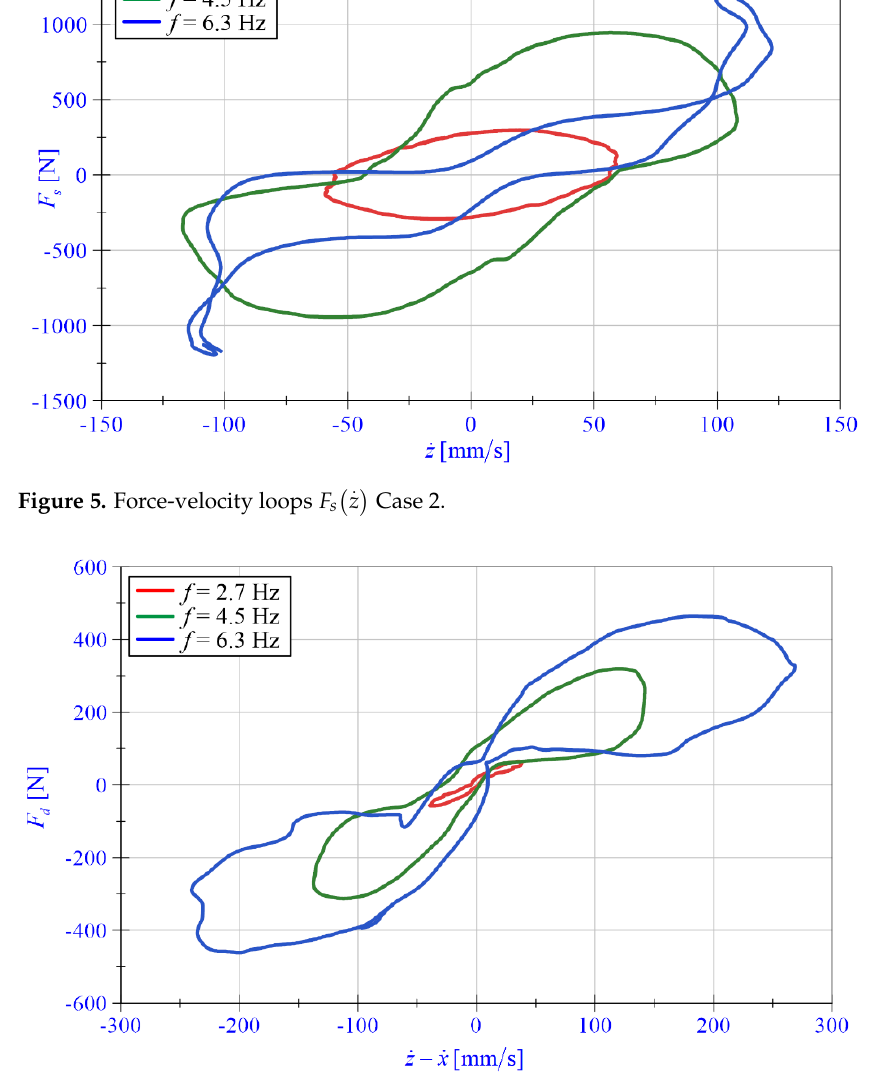
. (cid:0) . (cid:1) z − x Case d